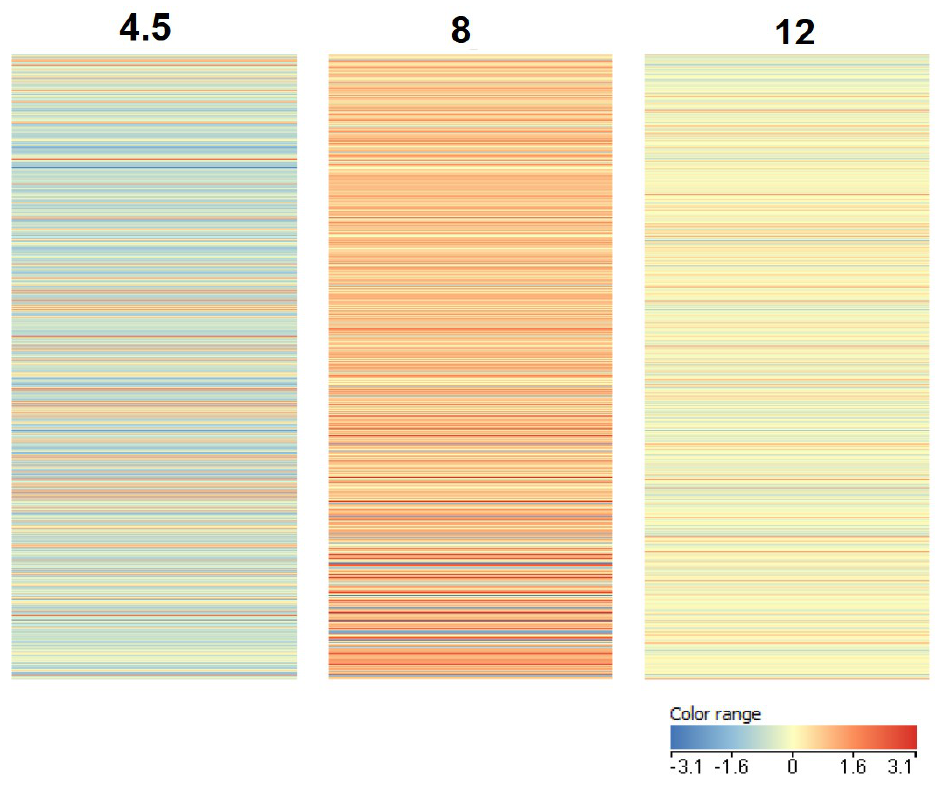
Figure 3. Heat maps of genes expressed at three time points of embryonic development of GP chicken: 4.5, 8, and 12 days.